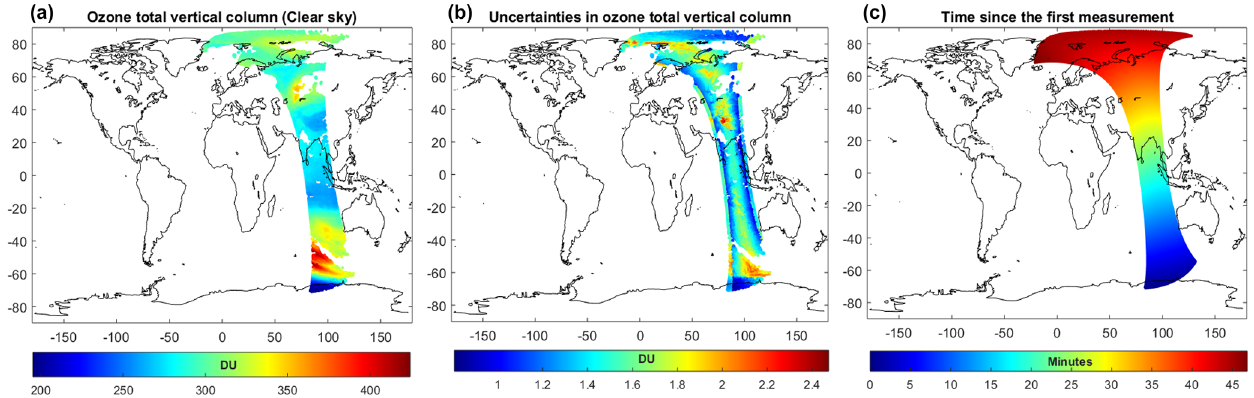
Figure 2. (a) TROPOMI clear-sky ozone measurements in one orbit (1 September 2018, 06:37UTC). (b) Uncertainties. (c) Time since the first measurement in this orbit.